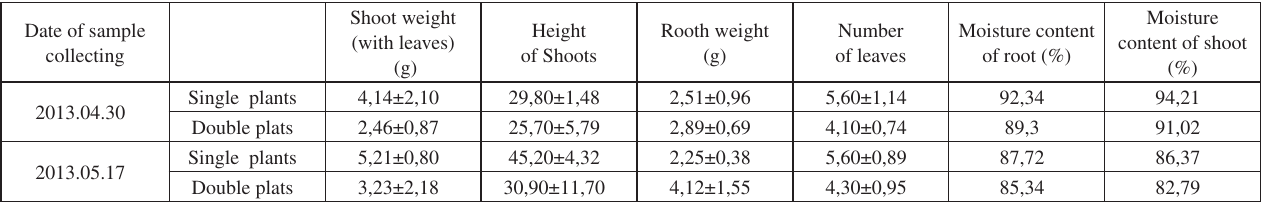
Table 3. Preliminary data of Nurse